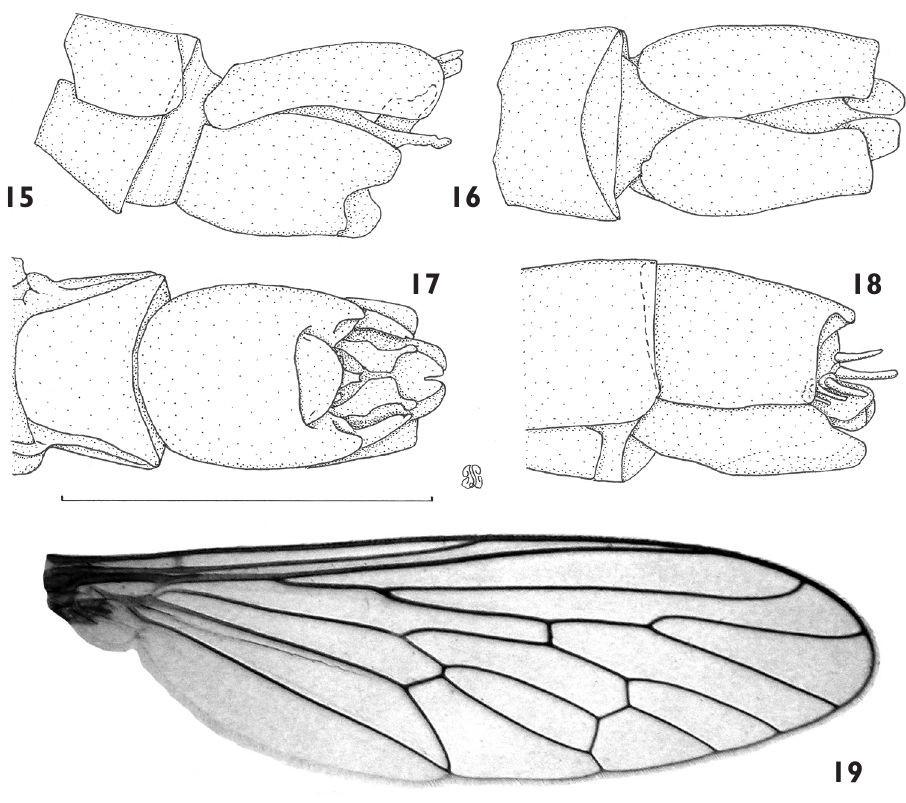
Figures 15–19. Male and female terminalia and wing of Trichoura pardeos sp. n.: 15 male, lateral 16 male, dorsal 17 male, ventral; 18 female lateral 19 wing. Scale bars: 1 mm. strongly silver pruinose, almost asetose except for c. 5 white katatergal macrosetae. An- episternal setae absent. Anatergites uniformly strongly gold pruinose, asetose. Legs: Coxae red-brown, strongly silver pruinose, white setose; metathoracic coxae with small bulbous protuberance on anterior surface. Femora red-brown with orange distal and proximal ends, white setose. Tibiae and tarsi orange, terminal parts red- brown, white setose. Claws black with brown-orange basal parts, shorter than ter- minal tarsomere, gently curved. Empodium orange, straight, slightly shorter than claws. Pulvilli pale yellow, longer than empodium. Wings (Fig. 19) length measured from humeral crossvein to tip, breadth at widest level: Holotype 1.3 × 0.4 mm, para- types – male (1) 1.4 × 0.5 mm, females (2) both 1.7 × 0.6 mm. Venation: C extends around wing margin terminating at junction of CuA+CuP, although it appears to extend weakly around at least part of cell cup. Alula reduced to a small lobe. All pe- ripheral cells open except for m and cua which are closed and stalked. Little variation 3 is evident. Veins mostly dark red-brown except proximally where veins are yellowish, membrane unstained, transparent, much of surface, especially distally,